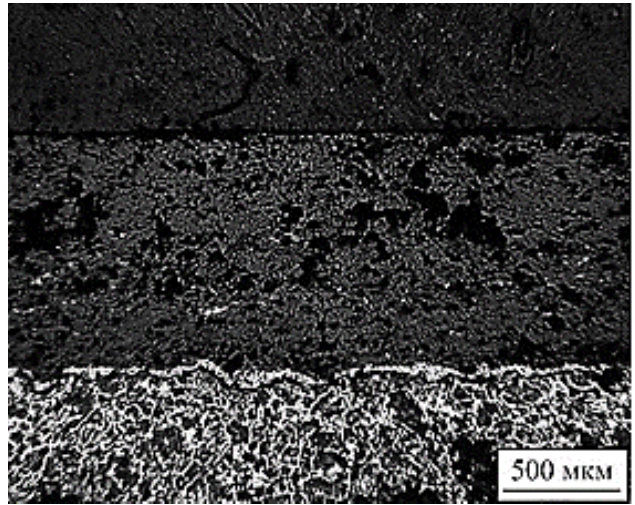
Figure 6. Measurement of microhardness of samples.